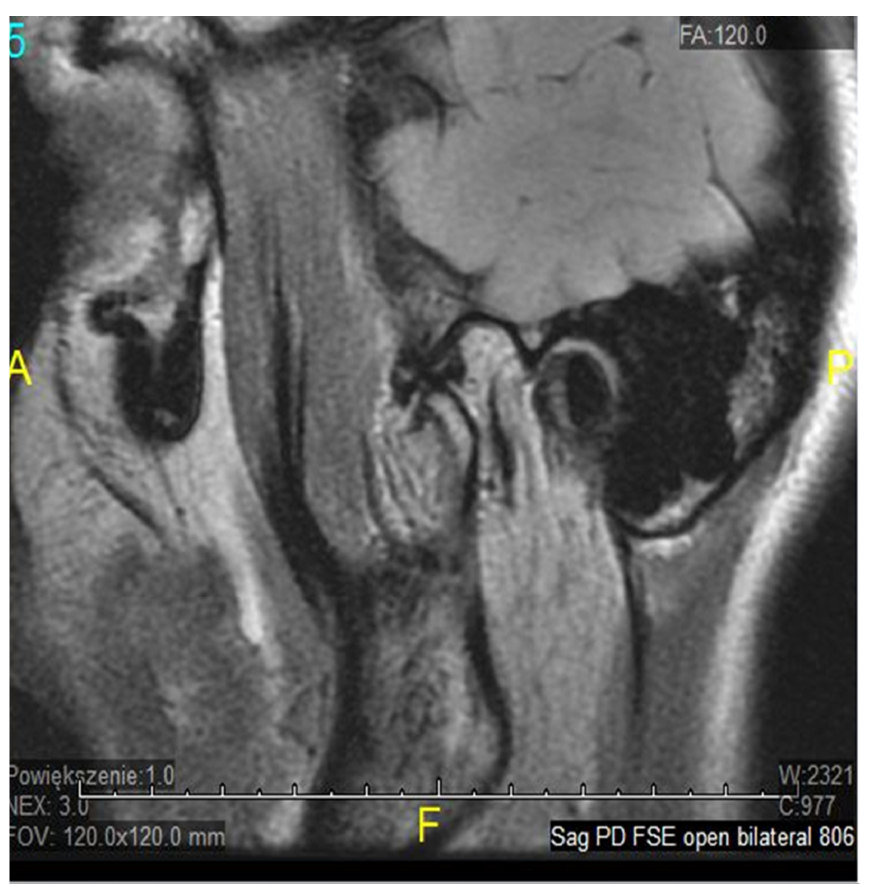
Figure 2. ADDwoR sagittal view—open. Magnetic Resonance Imaging (MRI) scans showed that in cases where no treatment has been administered, the displaced TMJ disc becomes deformed [12]. It was also found that unilateral DDwoR in young people can lead to asymmetry of the mandible over time [13]. Moreover, it has been proven that the severity of asymmetry increases with time and may require orthognathic surgery later in life [14]. The TMJ disc is connected in its dorsal part with an area of richly innervated and vascularized connective tissue. This tissue is defined as the bilaminar zone (BLZ). The lower layer is mainly composed of collagen fibers. In addition, the front part of the disc is connected from the top and bottom by trailers to the joint capsule. Both front trailers are made of collagen blocks [15]. Collagen XII is a fiber-bound, single gene encoded by COL12A1 , a member of the fibril- associated collagens with interrupted triple helices collagens (FACIT) located on human chromosome 6q12-q13. By providing unique molecular bridges between fibrils and other ECM components, the FACIT collagens tend to act as regulators of fibrillar scaffolds (Figure 1). Some partial correlation between COL12A1 Single Nucleotide Polymorphisms (SNPs) [16] and joint disorders was previously reported; however, just one of the studies brought up the relationship between rs970547 in COL12A1 with anterior cruciate ligament (ACL) rupture [17]. Nevertheless, more research on this subject is required in terms of other parts of the musculoskeletal system [1–4]. Furthermore, a connection between mutations in COL12A1 and Ehlers–Danlos Syndrome (EDS) has also been demonstrated [18]; whereas a major part of EDS symptomatology is strictly connected with GJH and hyper elastic skin, TMJ posterior band ligaments, which are primarily composed of collagen fibers defined by a certain length, have also been shown to play a significant role in preventing TMJ disc displacement [19]. We hypothesized that some IDs in the TMJ might be caused by impaired collagen quality and certain COL12A1 SNPs, yet a relationship to TMJ